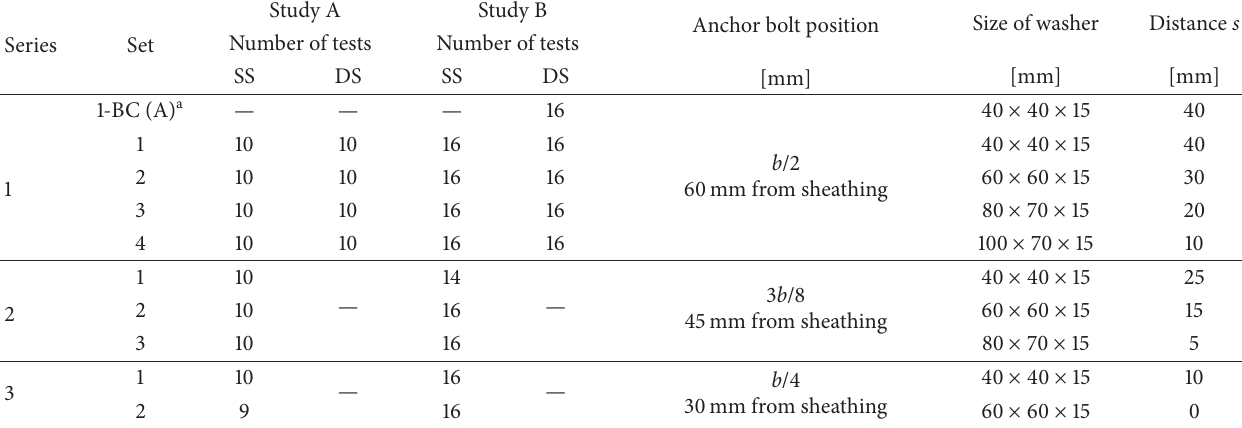
Table 1: Specification of specimen tested in study A and study B. Notation: SS = single-sided specimens, DS = double-sided specimens, b = width of rail, and s = distance from washer edge to loaded edge of the bottom rail (cf. Figure 1).